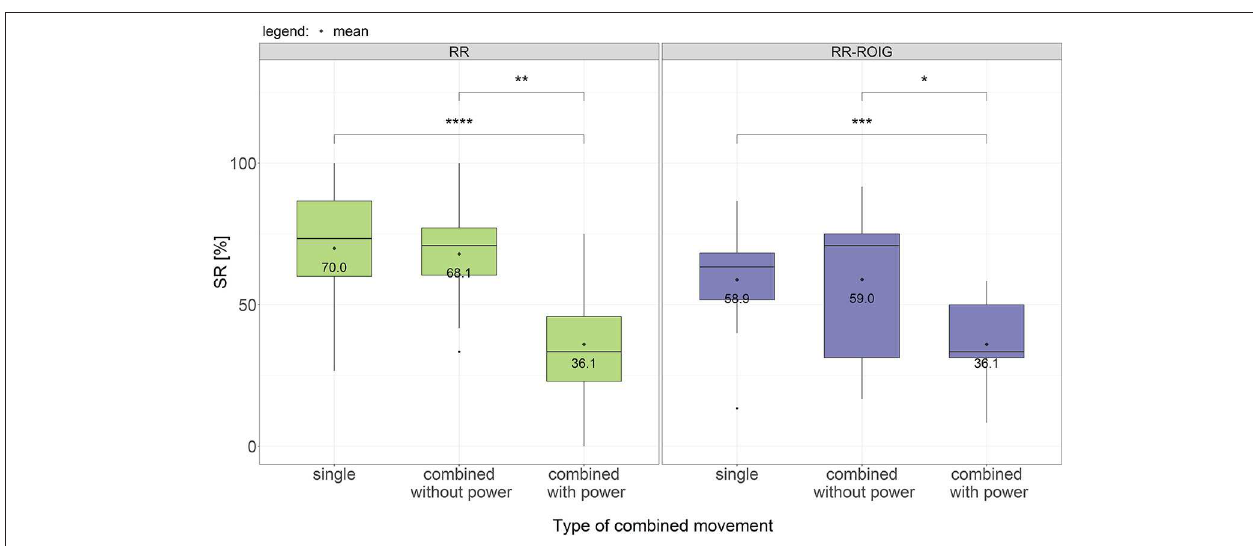
FIGURE 9 | Boxplots and means of the success rates across all participants grouped according to the machine learning method and the type of combined movement used. * p ≤ 0.05; ** p ≤ 0.01; *** p ≤ 0.001; **** p ≤ 0.0001.